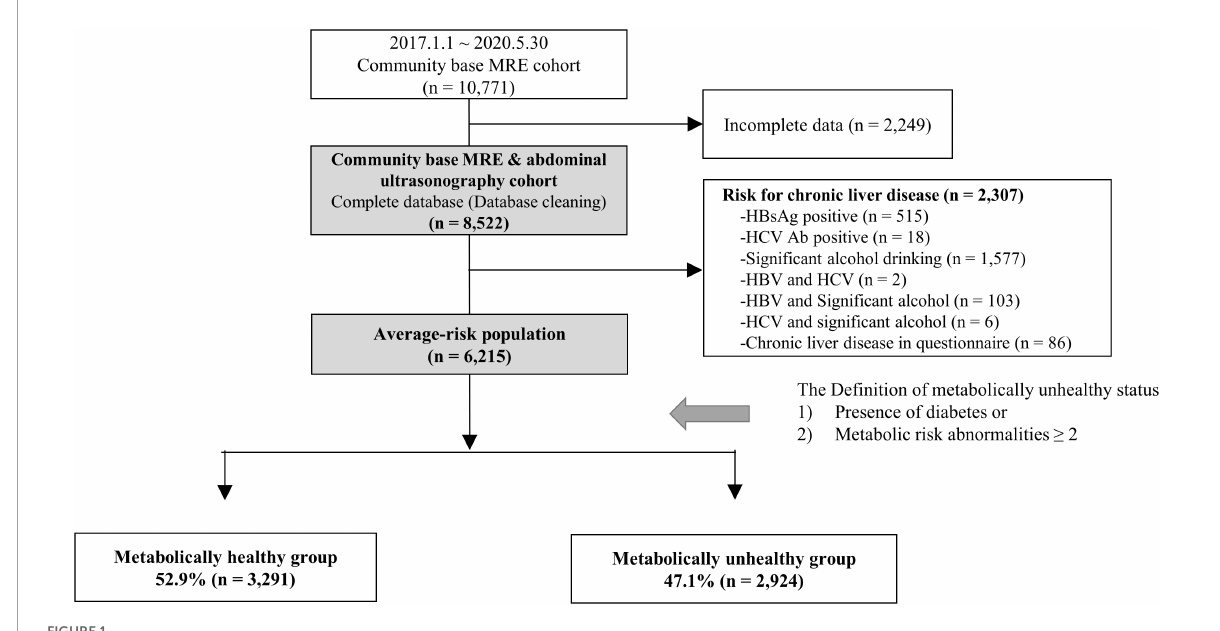
FIGURE1 Study flow. MRE, magnetic resonance